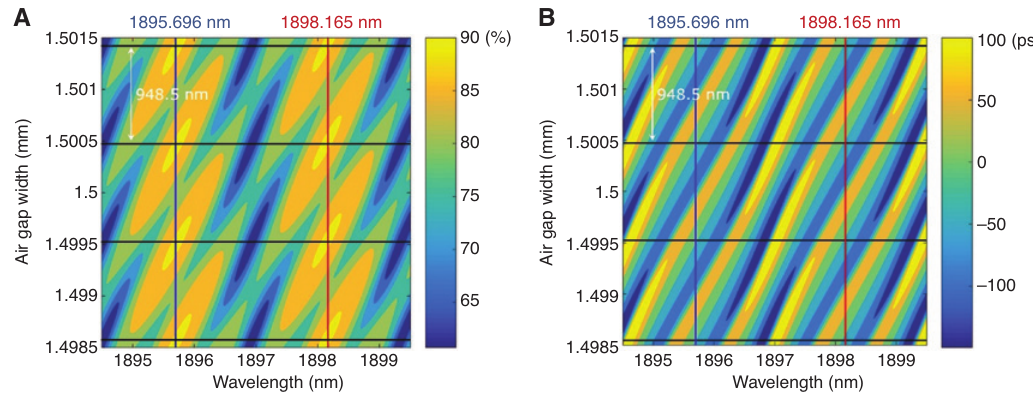
Figure 5: Numerical analysis of the TSI. (A) Reflectivity map of the TSI versus the air gap width and laser wavelength. The vertical blue and red line shows two emission band centers of the mode-locking operation. The horizontal black lines indicate the air gap adjusting period (1500471.55 nm + k × 948.5 nm, k = 0, ± 1, ± 2, … ), where a maximum reflectivity is obtained at the lasing wavelength. (B) GDD map of the TSI as a function of the air gap width and the laser